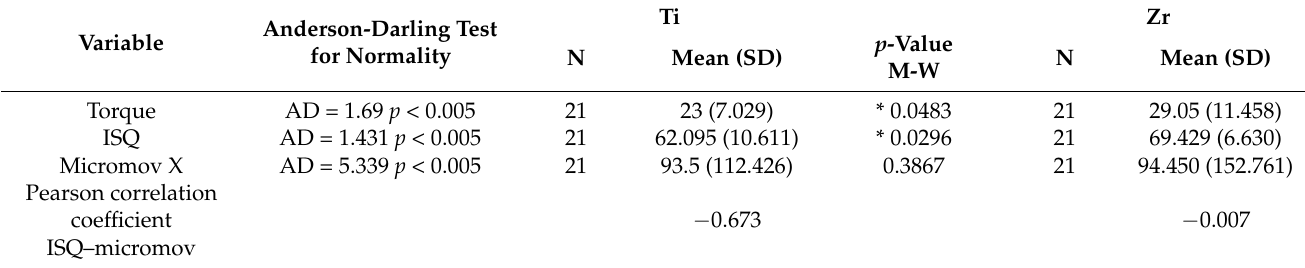
Table 1. Descriptive statistics (mean and SD) of the dependent variables analyzed (insertion torque, resonance frequency analysis, and micromovement) and statistical significance of the differences between independent variables (titanium and zirconia) * Statistically significant ( α = 0.05; p < 0.05).